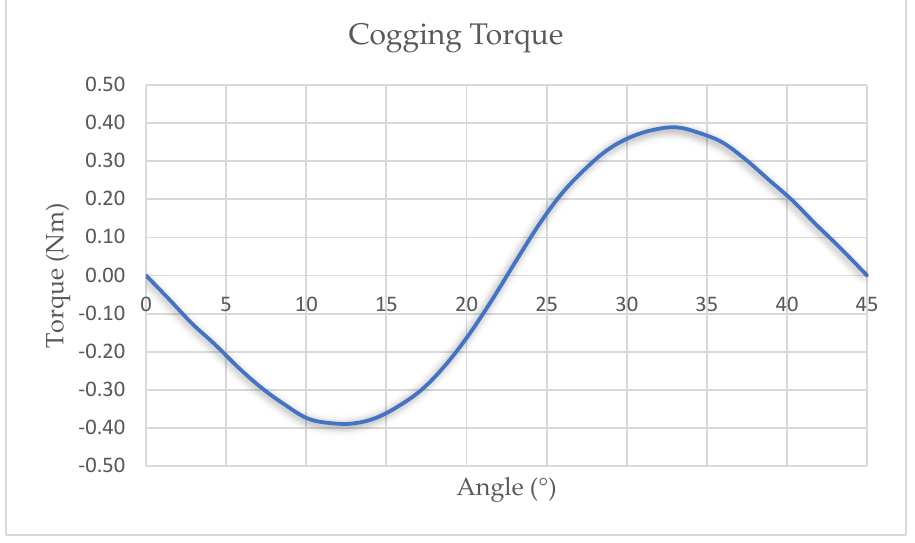
Figure 11. Cogging torque.